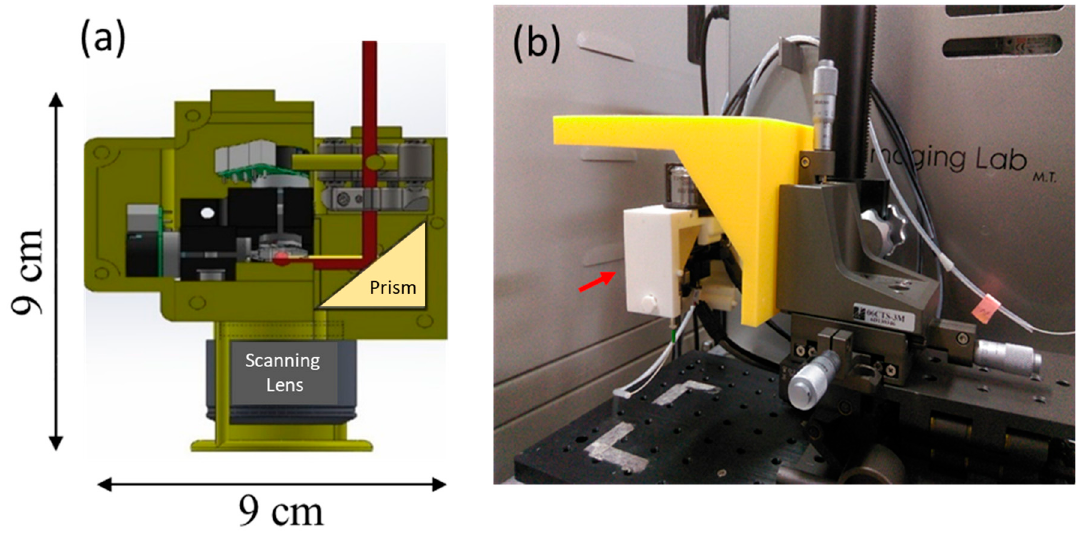
Figure 2. ( a ) Layout of the portable probe and ( b ) Photograph of the portable OCT.